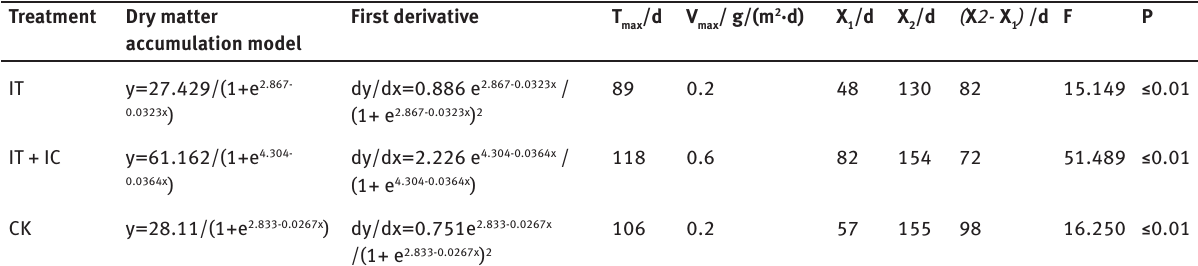
Table 2: Dynamic simulation and characteristic parameters of dry matter accumulation for potato petiole in different treatments. Treatment Dry matter accumulation model